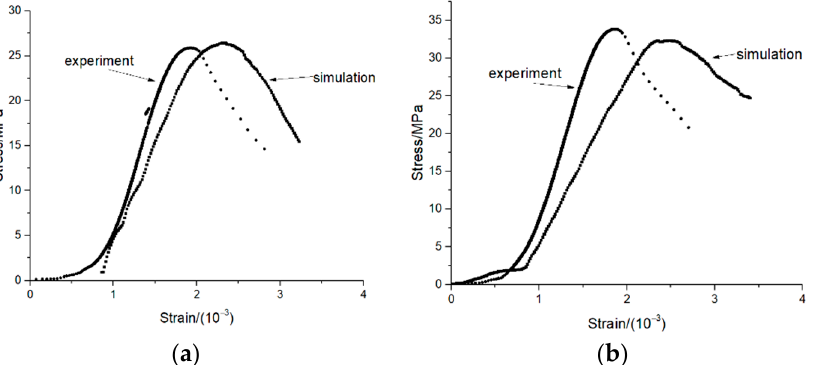
Figure 10. Test and simulated stress–strain diagram of specimens. ( a ) Ordinary concrete. ( b ) Nano- TiO 2 modified concrete.